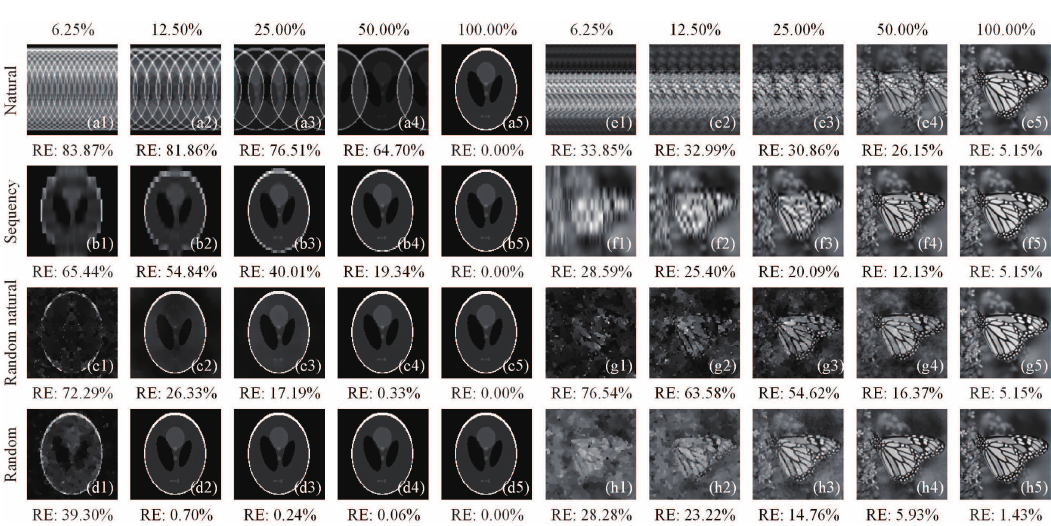
Figure 1. Reconstructed images of head phantom image and monarch butterfly image (with more complicated structure) from: ( a1 – a5 , e1 – e5 ) natural-ordered; ( b1 – b5 , f1 – f5 ) sequency-ordered; ( c1 – c5 , g1 – g5 ) random-natural-ordered Hadamard matrix; and ( d1 – d5 , h1 – h5 ) totally random measurement matrix with different sampling ratios of 6.25%, 12.50%, 25.00%, 50.00% and 100%. Note that the random-natural-ordered Hadamard matrix only randomly rearranges the rows of the natural-ordered Hadamard